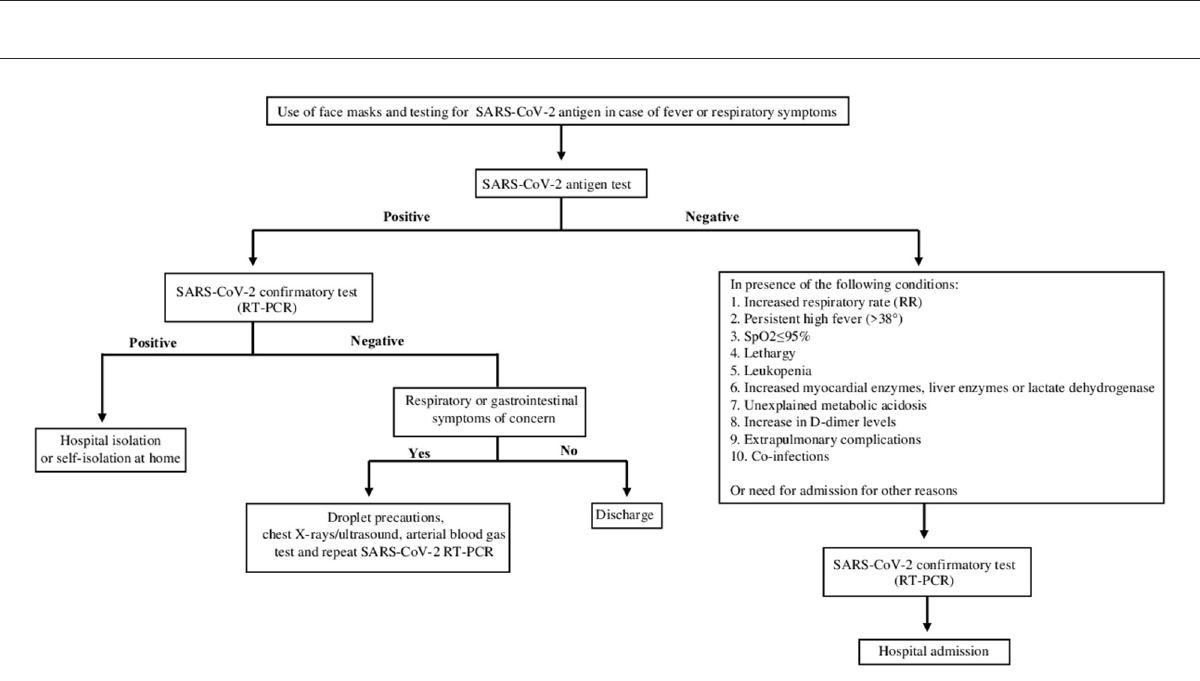
FIGURE2 Algorithm for diagnosis SARS-CoV-2 infection in patients who presented to the ED from 1 November 2020 – 31 December 2021 (Period B). The patients with symptoms suggestive of SARS-CoV-2 infection were tested initially by antigenic-test with the SD Biosensor STANDARD F COVID-19 Ag. Then, patients with a positive antigen result and those with a negative antigen result but with one of the following clinical or laboratory criteria shown in the figure were subsequently evaluated by molecular swab